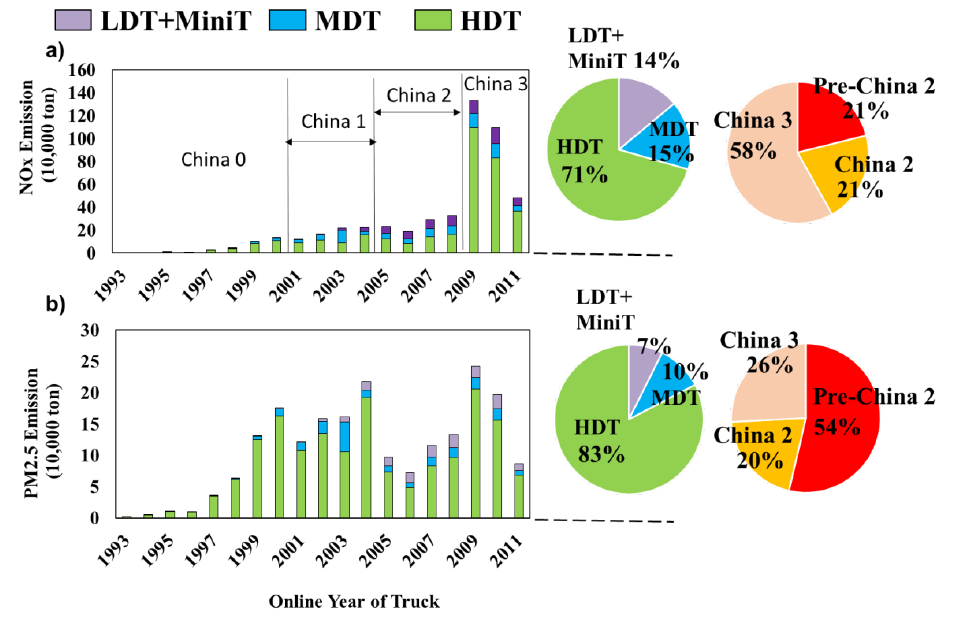
Figure 7. Emissions from diesel-truck fleet in 2011, China: (a) NO x emissions and (b) PM 2 . 5 emissions.